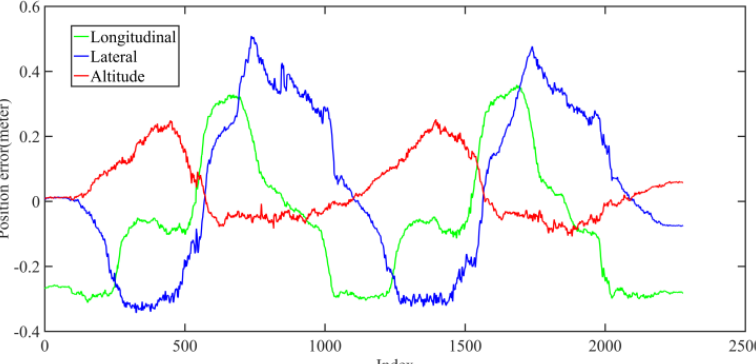
Figure 27. Field test NO.3. Two laps under normal driving scenario localization test trajectory comparison. The comparison of fused trajectory with groundtruth.